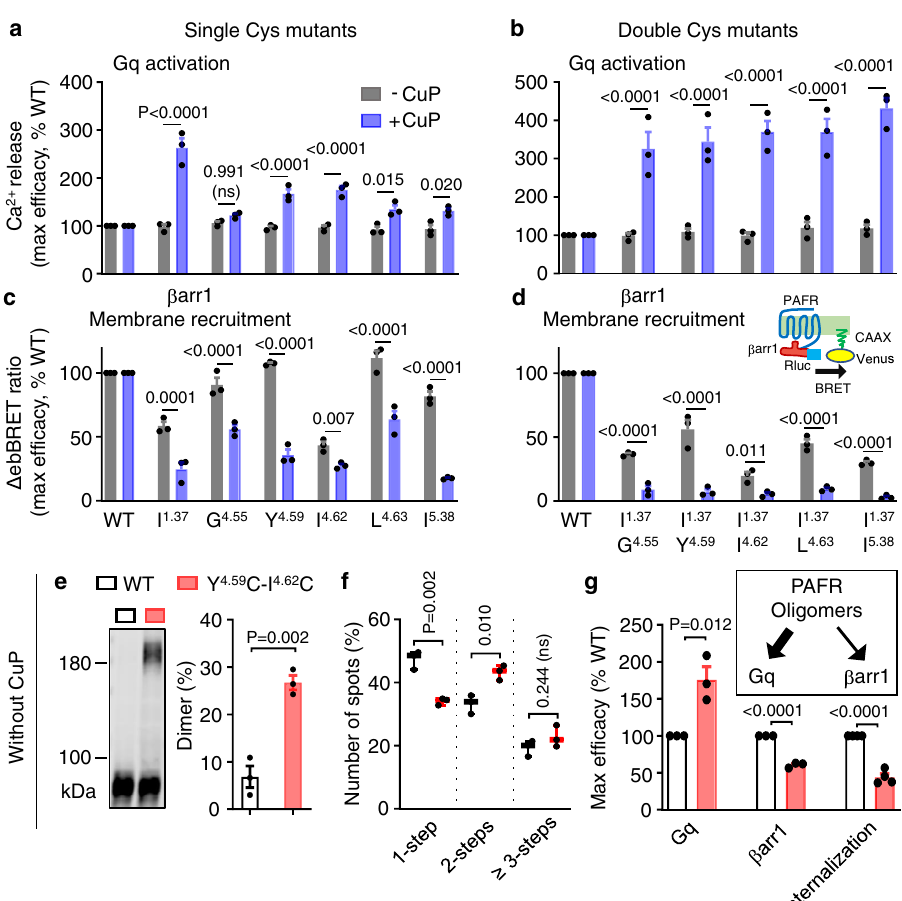
Fig.4|PAFRoligomersdistinctlymodulateGproteinactivationand β -arrestin recruitment.a , b IntracellularCa 2+ responsesmediatedbytheindicatedsingleand double Cys substitutions in the indicated TM upon stimulation with PAF. The indicated maximal ef fi cacy is from the dose – response in Supplementary Fig. 7b, c. c , d Recruitment of β arr1 to the cell membrane by the indicated mutants upon stimulation with PAF (1 μ M) and monitored by the variation of ebBRET signal between β arr1-Rluc and Venus-CAAX. The indicated maximal ef fi cacy is from Sup- plementary Fig. 8b, c. Data in panels a – d are mean±SEM from n =3 biologically independentexperimentsandwereanalyzedusingone-wayANOVAwithDunnett ’ s multiple comparisons test. e Blots showing cross-linking of the cell surface Halo- PAFRsubunitscontainingadoublecysteinesubstitutioninTM4(Y151C 4.59 -I154C 4.62 ) asindicated without treatment with CuP.Data are mean±SEM of n =3 biologically